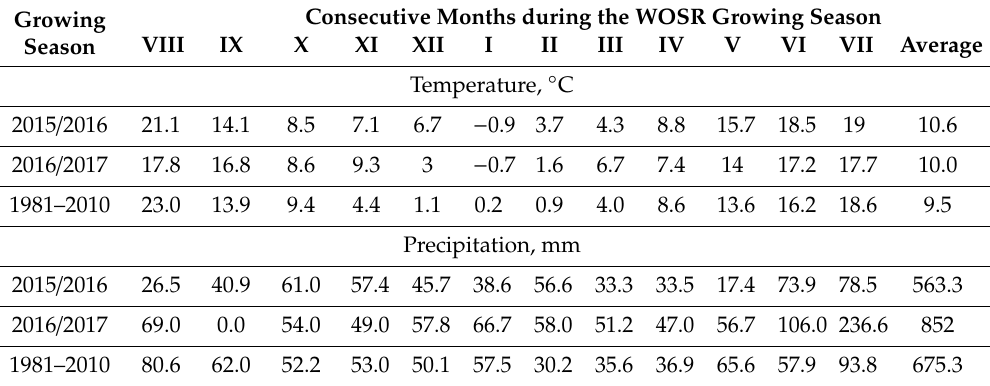
Table 2. Main characteristics of meteorological conditions during the winter oilseed rape (WOSR) growing season on the background of the long-term averages 1 .